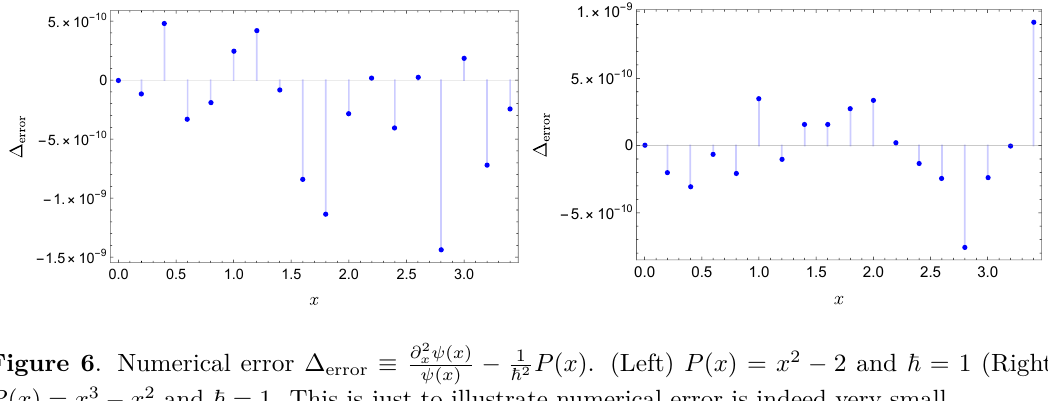
2 − 1 P ( x ) . (Left) P ( x ) = x 2 − 2 and ~ = 1 (Right) x ψ ( x ) ~ 2 ψ ( x )